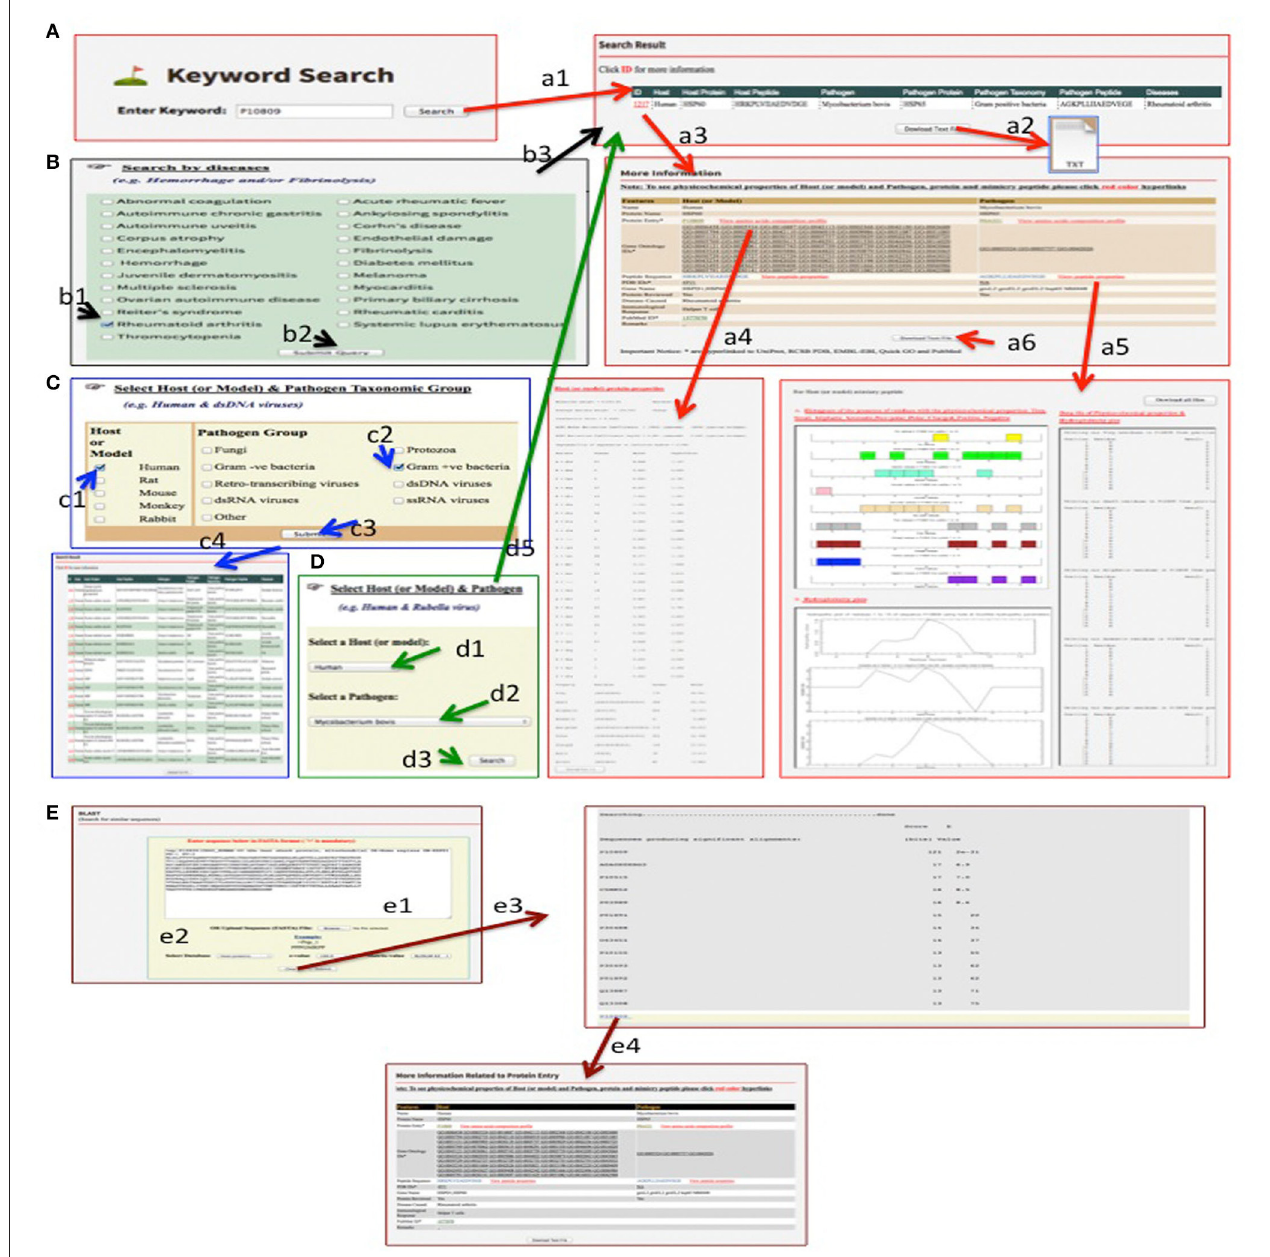
FIGURE 3 | Process of stepwise data retrieval and analysis in miPepBase. The user can search query with following options: (A) Keyword search, (B) Search by disease, (C) Search by host and pathogen taxonomic group, (D) Search by host and pathogen name. The search from (A–D) options display search result table and from that user can select the entry/displayed result for further detailed analysis. Sequence based search can also be searched by (E) BLAST search option and each hit is further linked to its details information page. The detail of result obtained from search options (A–E) is displayed by corresponding small case (the